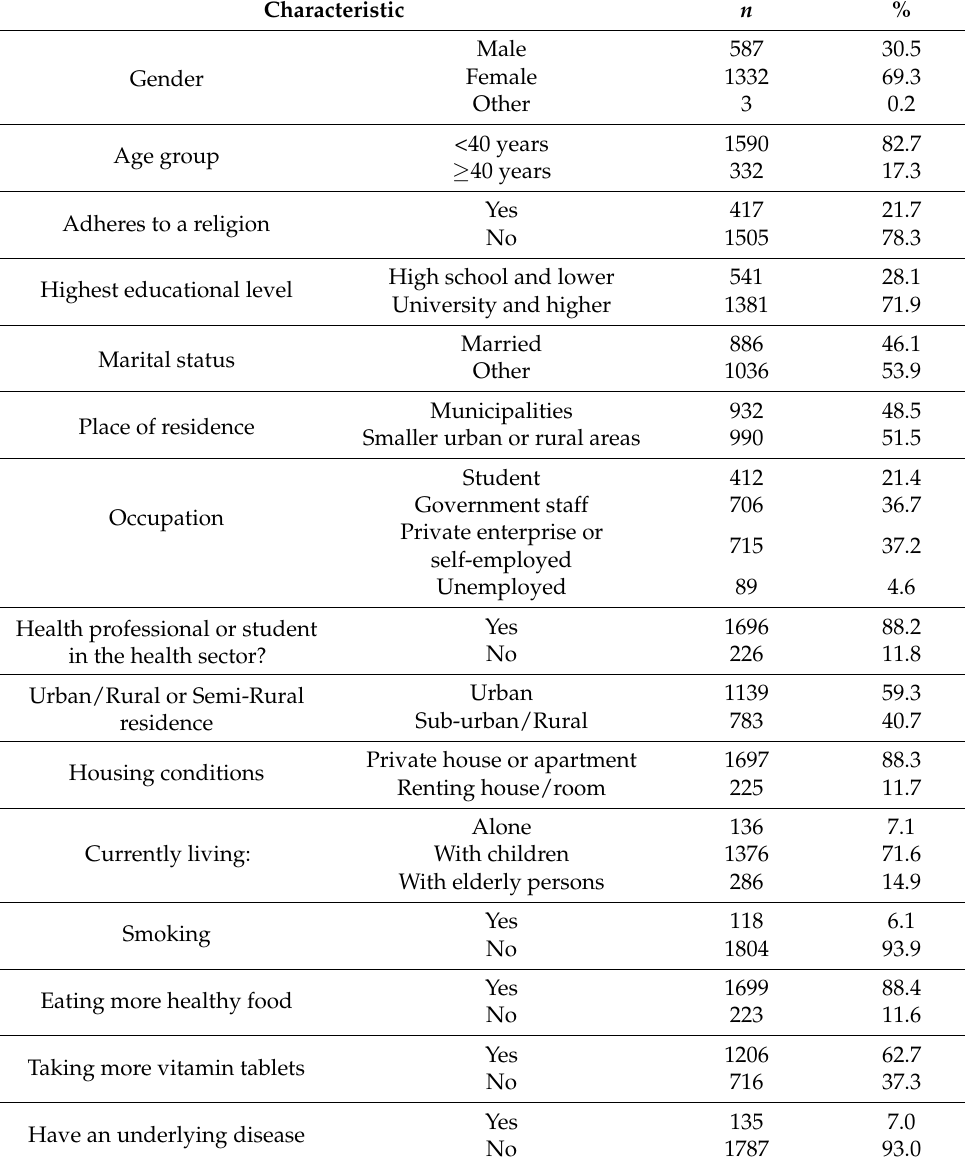
Table 2. Characteristics of the study participants ( n =